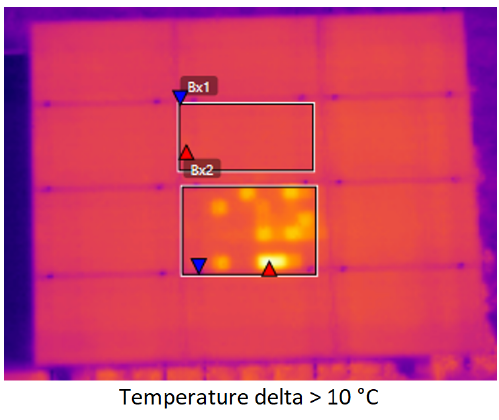
Figure 9. IR image analyzed for case 37. In this one, the heating generated in a solar PV module due to the presence of a short circuit is observed.